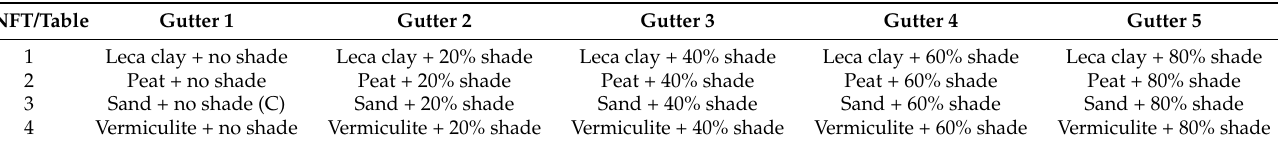
Table 1. Arrangement of each gutter on four NFT systems with different media and shade